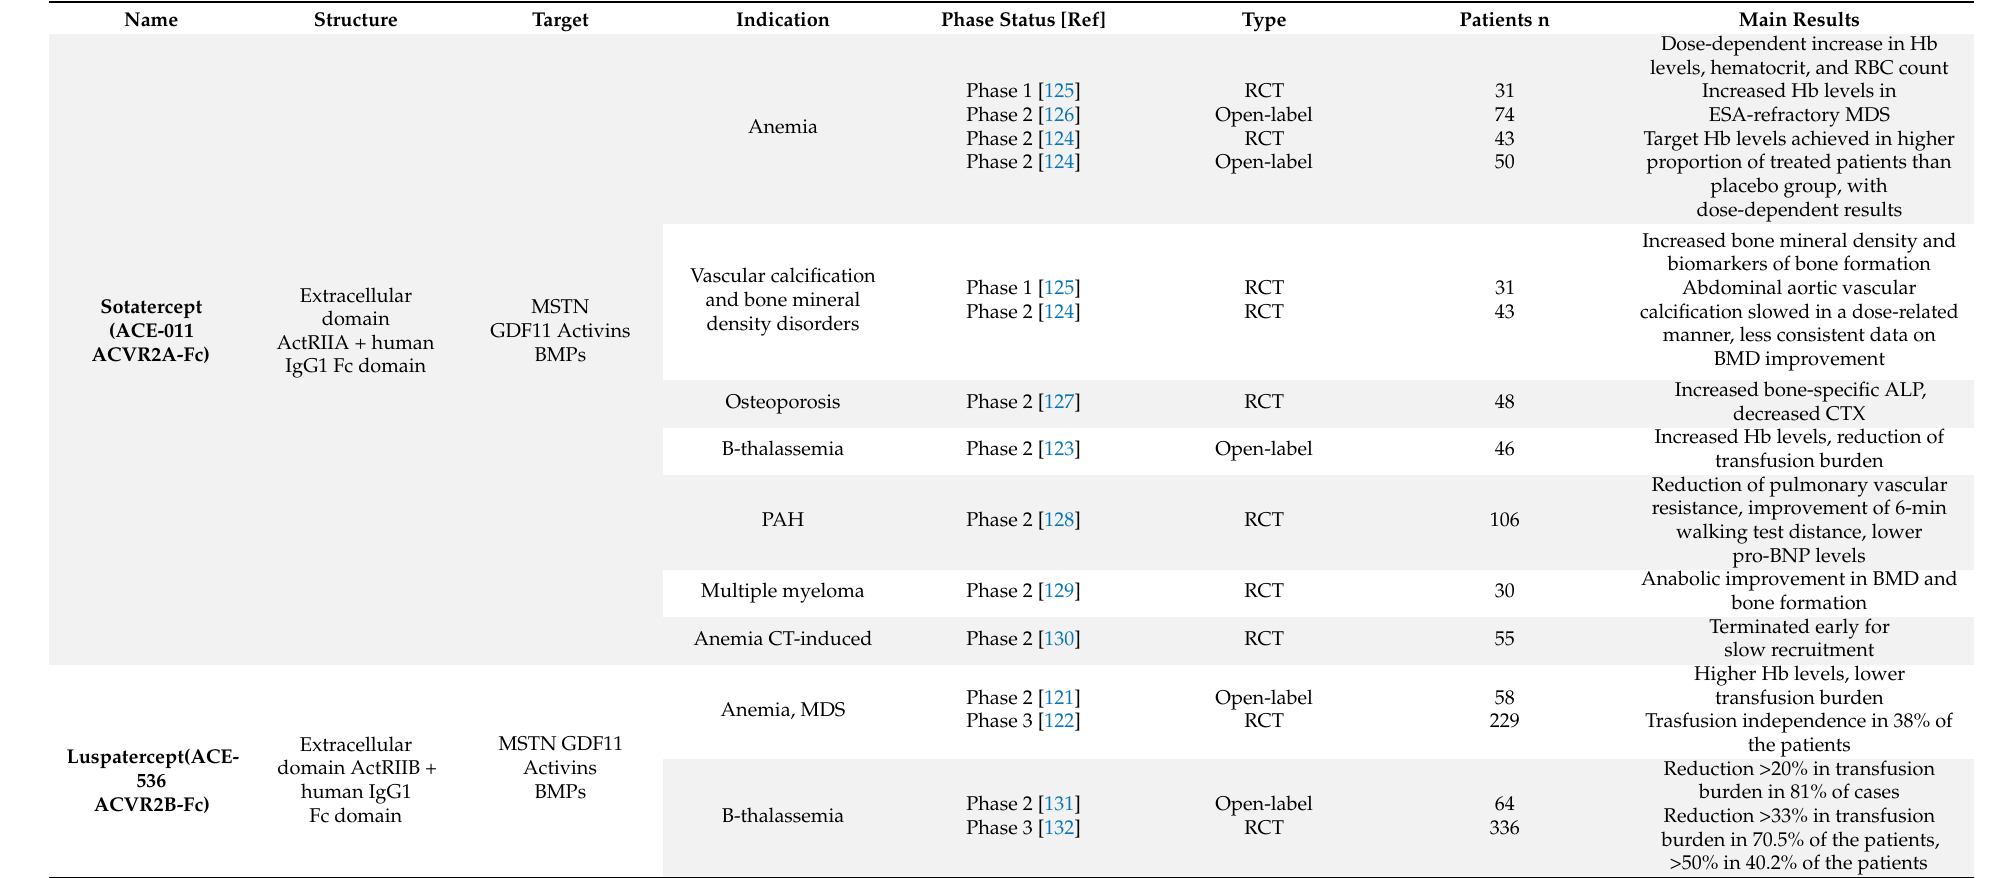
Table 1. Clinical trials of sotatercept and